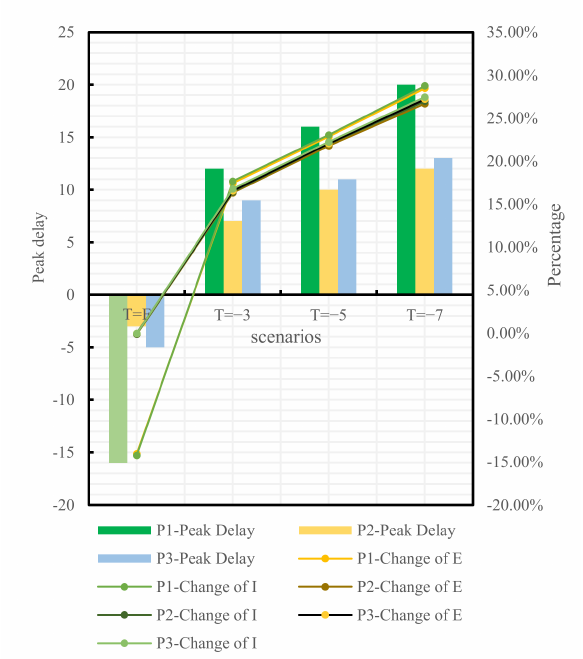
Figure 12. Comparison between T = F, − 3, − 5, − 7, and T = 0 of different